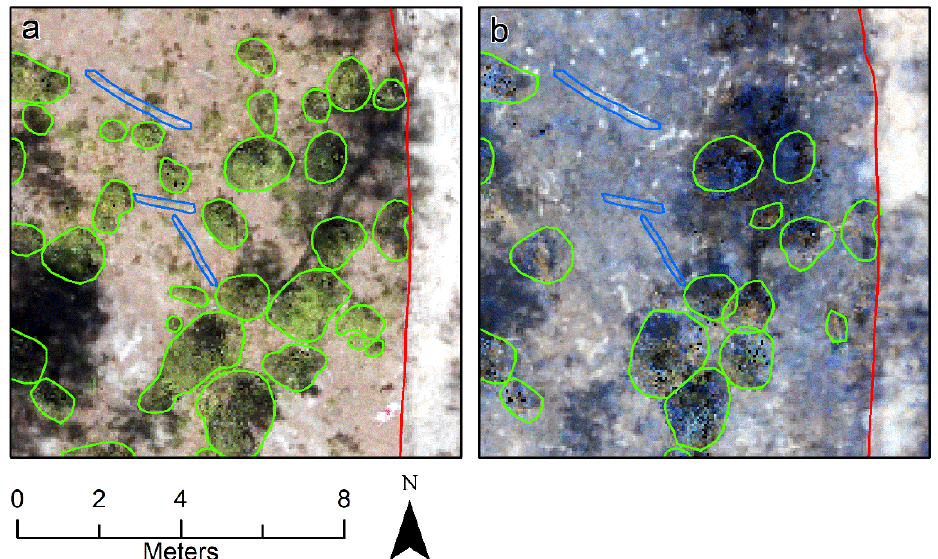
Figure 6. Examples of digitized sparkleberry (in green) and downed/burned logs (in blue) from burn unit 16D5, ( a ) prefire and ( b ) postfire. The red line depicts the east edge of the burn unit, bounded by the brighter bulldozer line to the east.